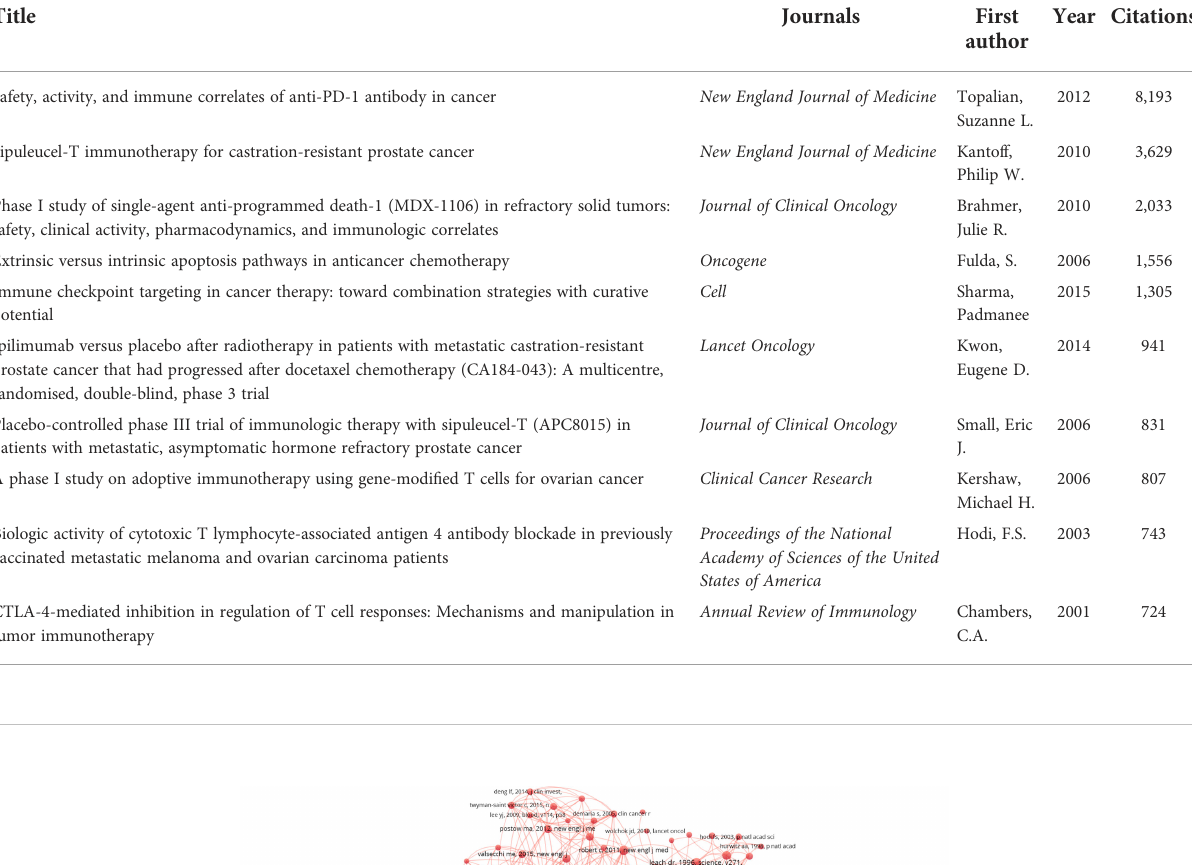
TABLE 3 Top 10 original articles concerning the research of PCa